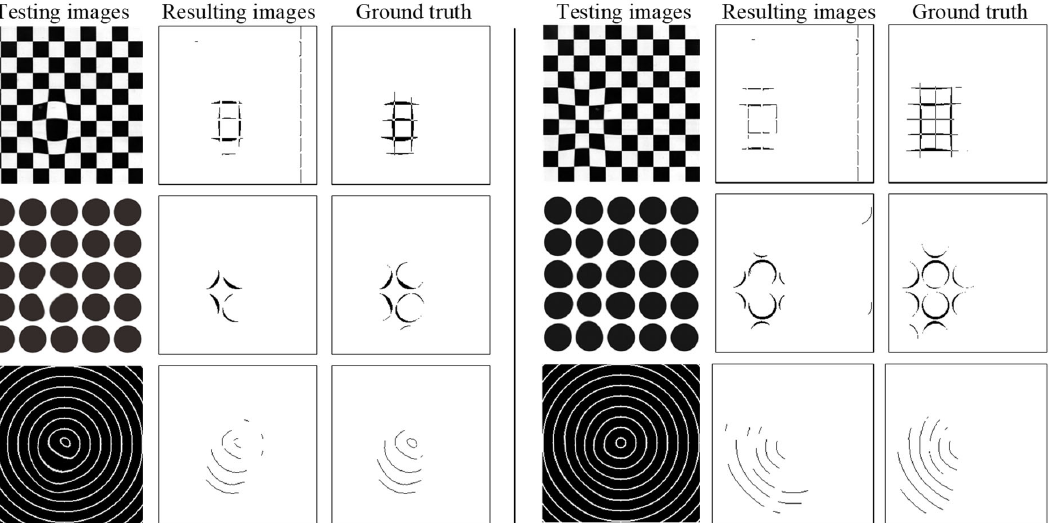
Fig. 10. Partial results of imaging distortion inspection by the Lin and Lo method and the proposed method using three common standard patterns